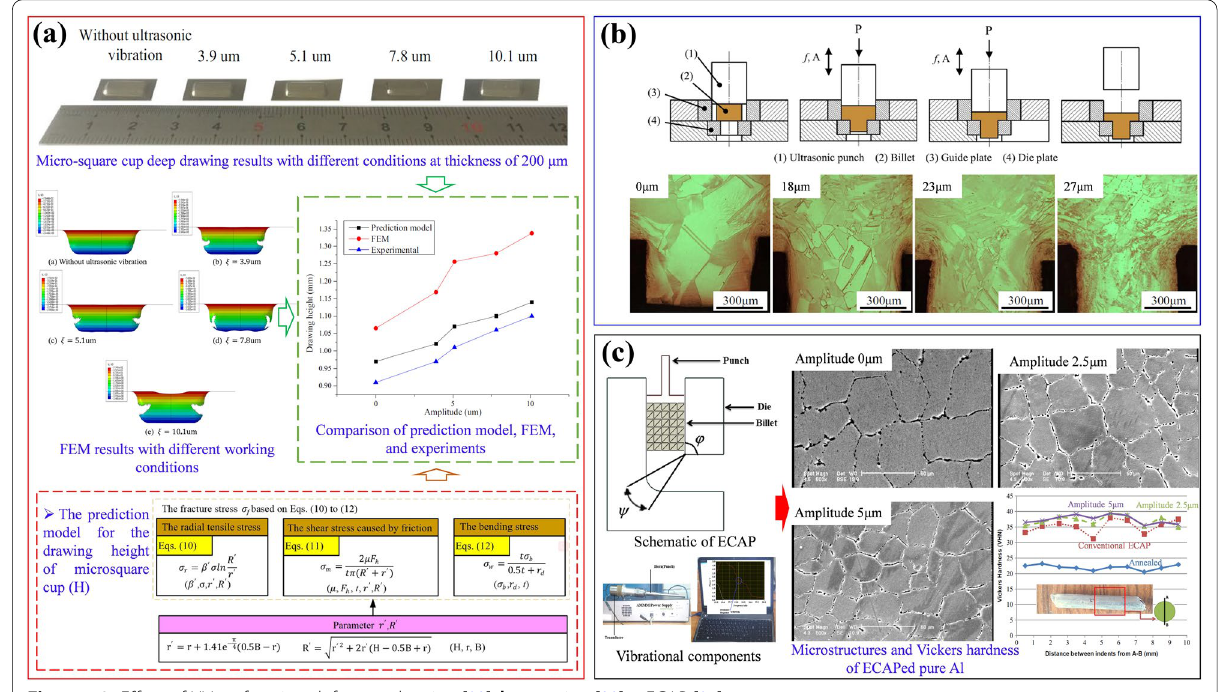
Figure 13 Effect of UV on forming defects: a drawing [93], b extrusion [82], c ECAP